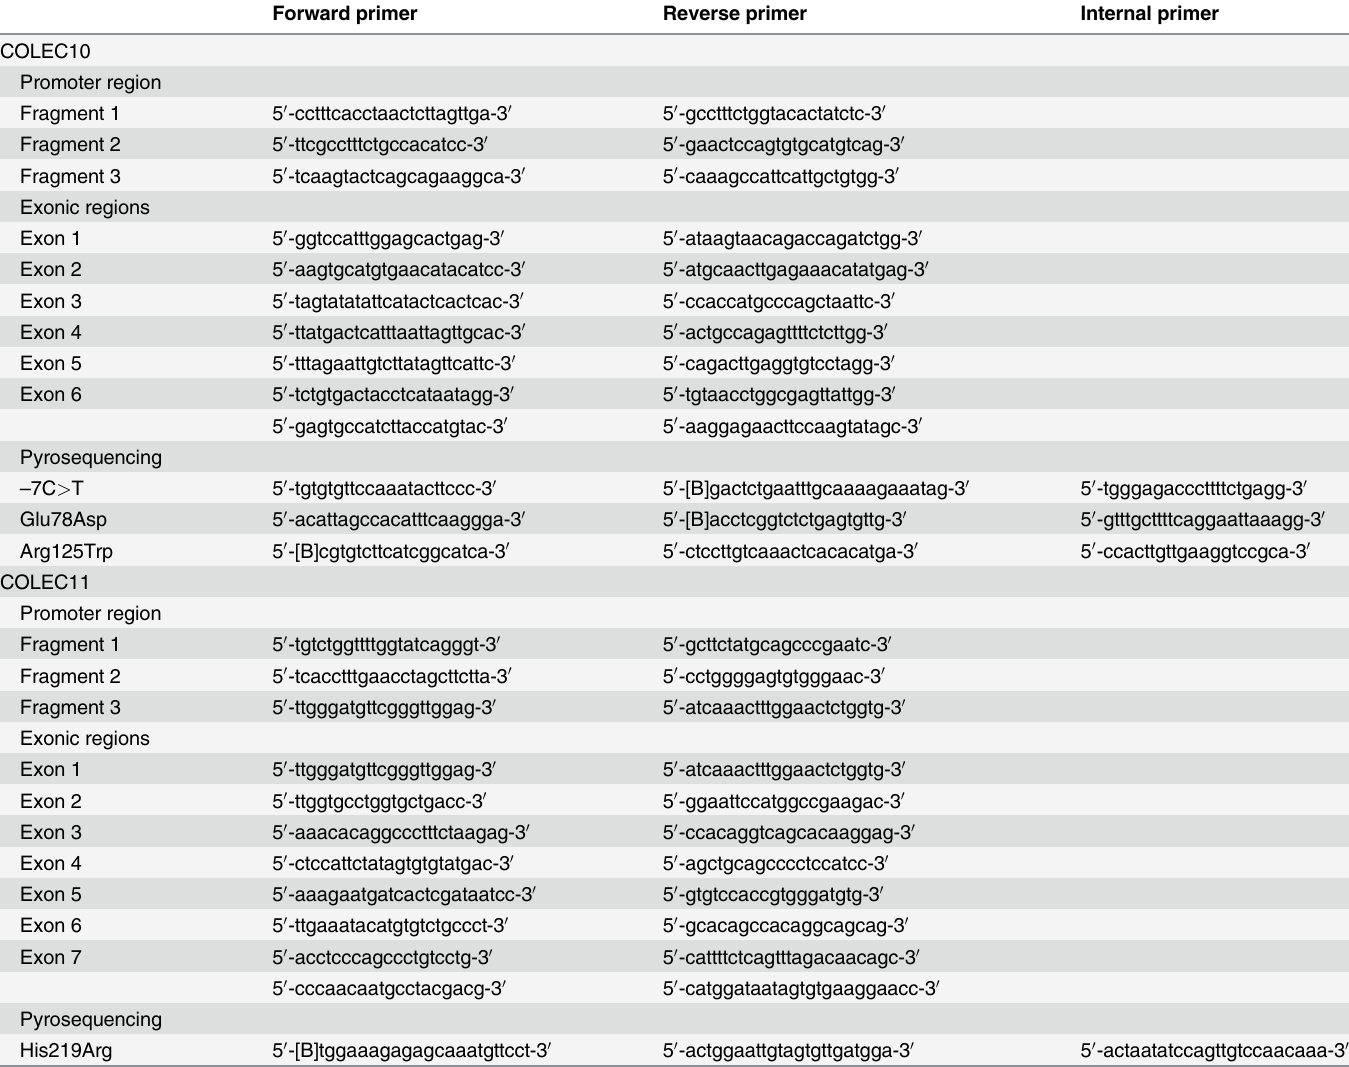
Table 1. COLEC10 and COLEC11 primer